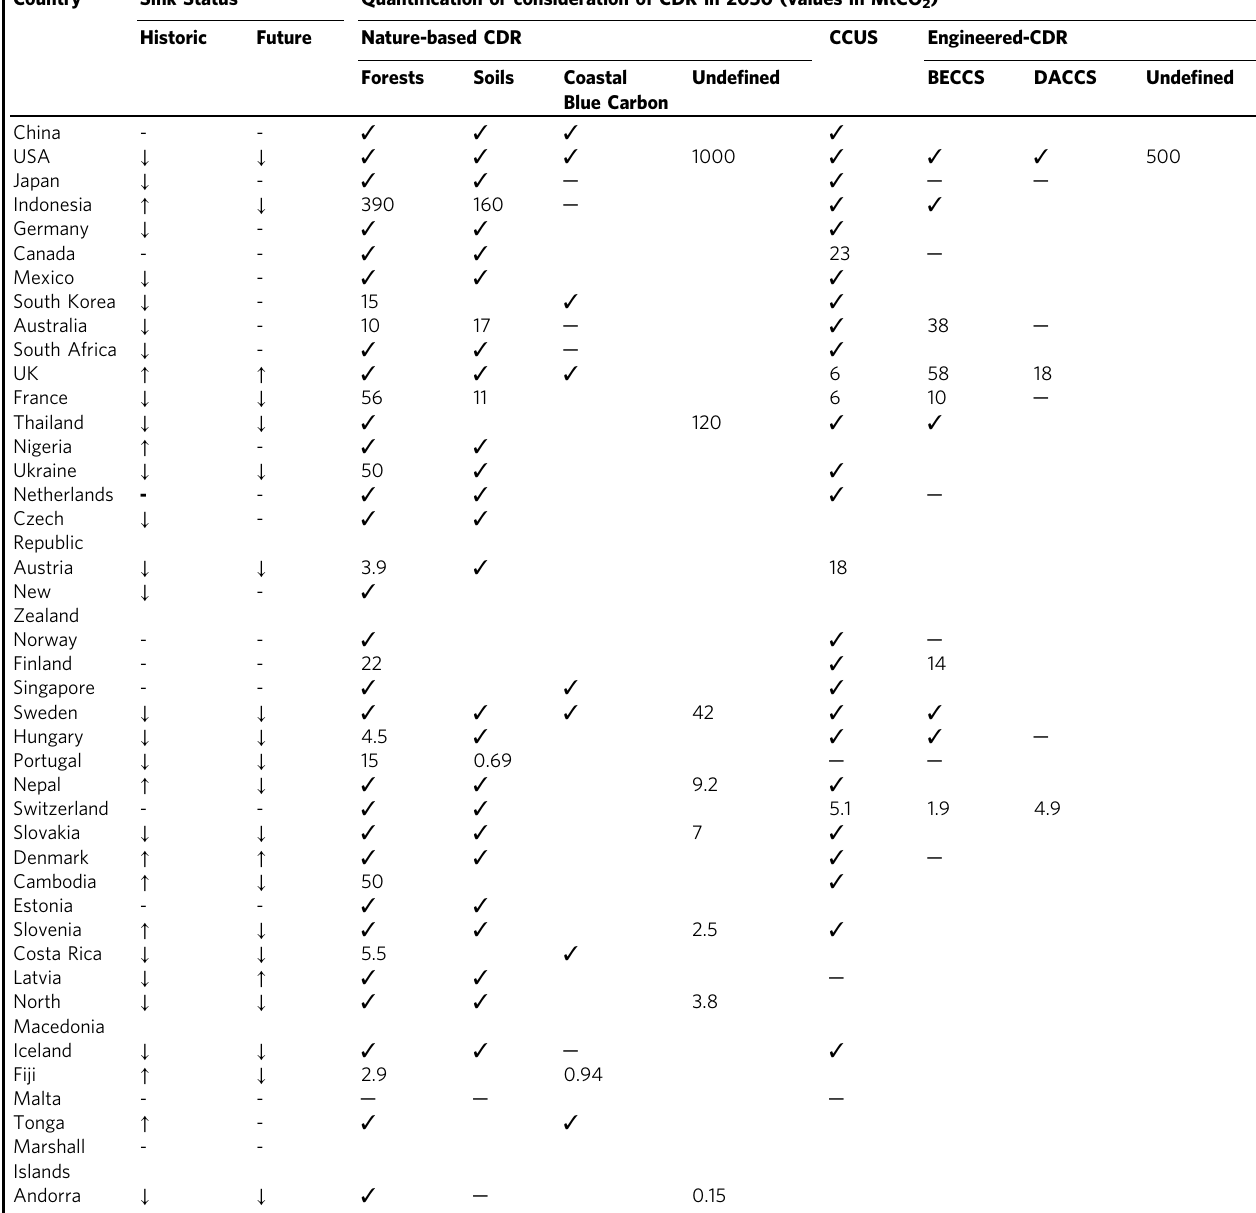
Table 2 Modelled quanti fi cation, qualitative consideration, or speculative consideration of Carbon Dioxide Removal (CDR) methods contained in long-term national climate